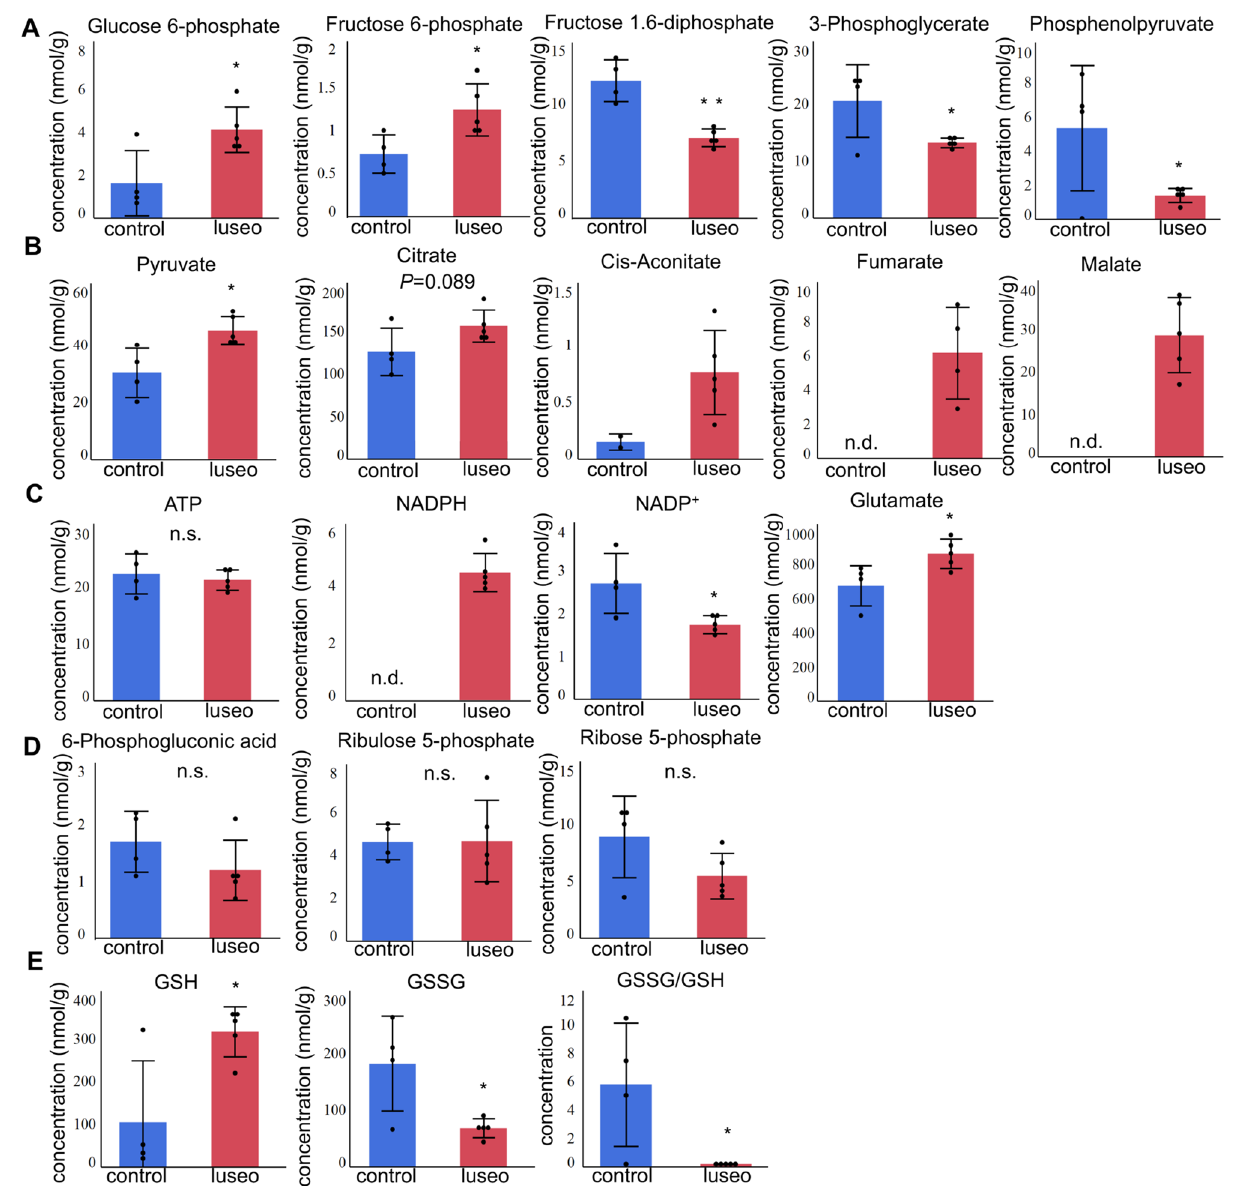
Figure 5. Effects of luseogliflozin on the metabolite concentrations in the pancreatic islets of 10-week-old db/ db mice. ( A ) Metabolites involved in glycolysis in pancreatic islets from the control ( n = 4) and luseo ( n = 5) groups. ( B ) Metabolites involved in the TCA cycle in pancreatic islets from the control ( n = 4) and luseo ( n = 5) groups. (C ) Concentrations of ATP, NADPH, NADP + , and glutamate in pancreatic islets from the control ( n = 4) and luseo ( n = 5) groups. ( D) Metabolites involved in the pentose phosphate pathway in pancreatic islets from the control ( n = 4) and luseo ( n = 5) groups. (E) Metabolites involved in glutathione metabolism in pancreatic islets from the control ( n = 4) and luseo ( n = 5) groups. Values are mean ± SD. P values were determined using Student’s t test. * P < 0.05; ** P < 0.01. n.d., not detected; n.s.; not significant, GSH; reduced glutathione, GSSG; oxidized